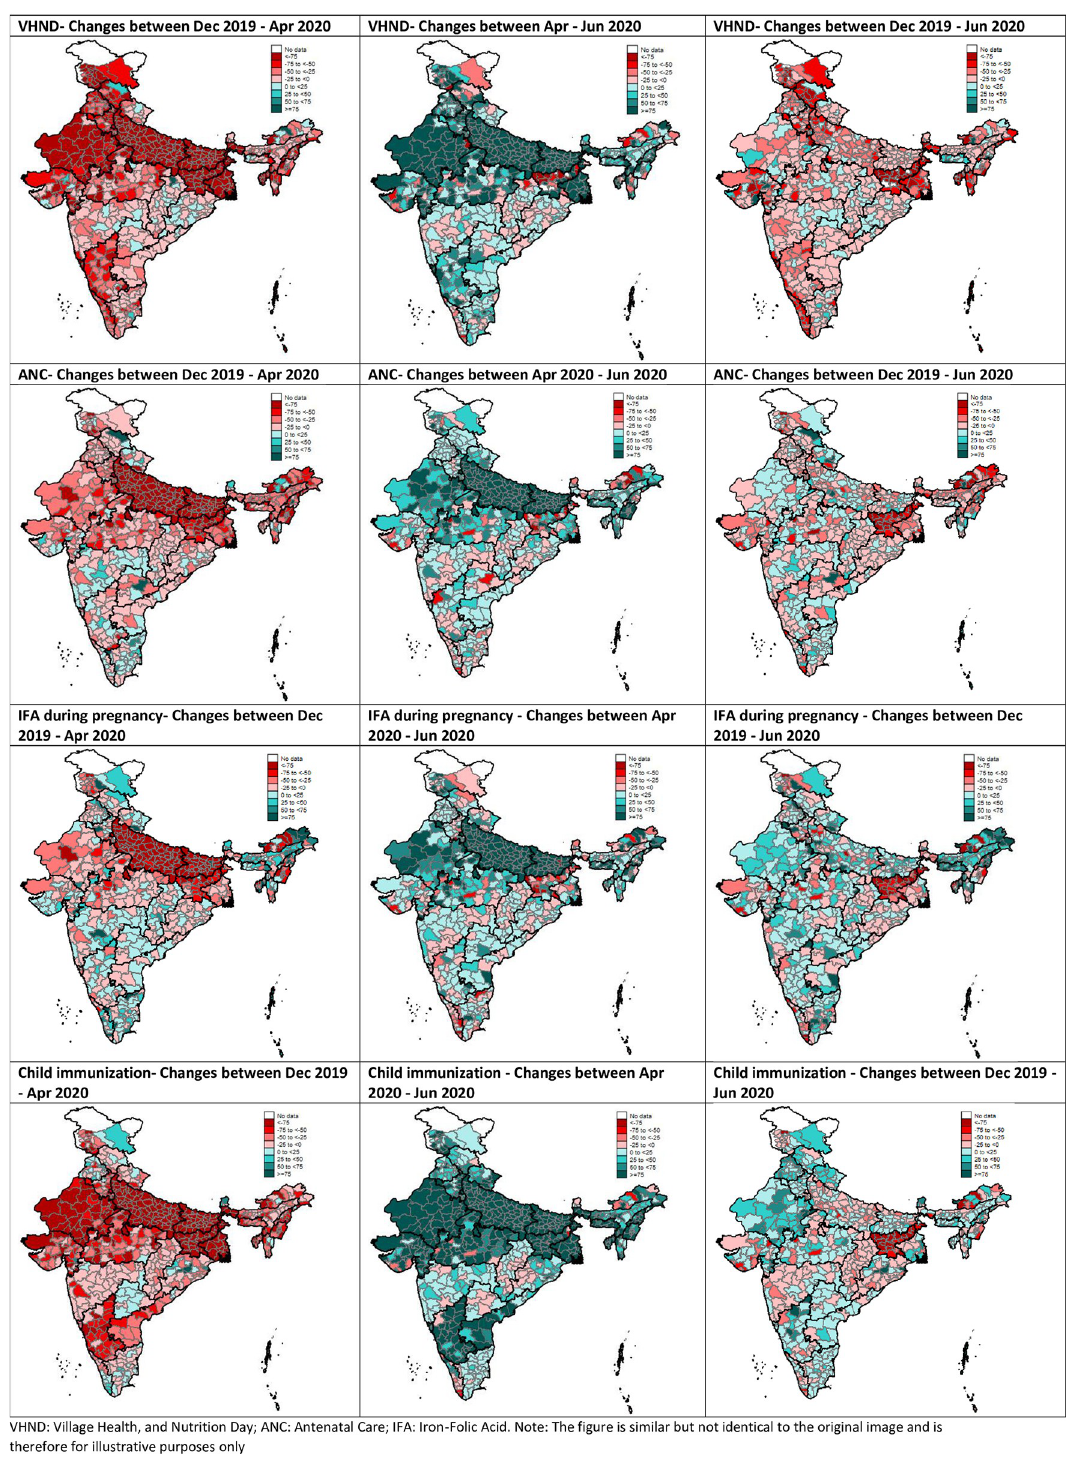
Fig 3. Services disruption and restoration during the COVID pandemic: Results from health management information system data. VHND: Village Health, and Nutrition Day; ANC: Antenatal Care; IFA: Iron-Folic Acid.